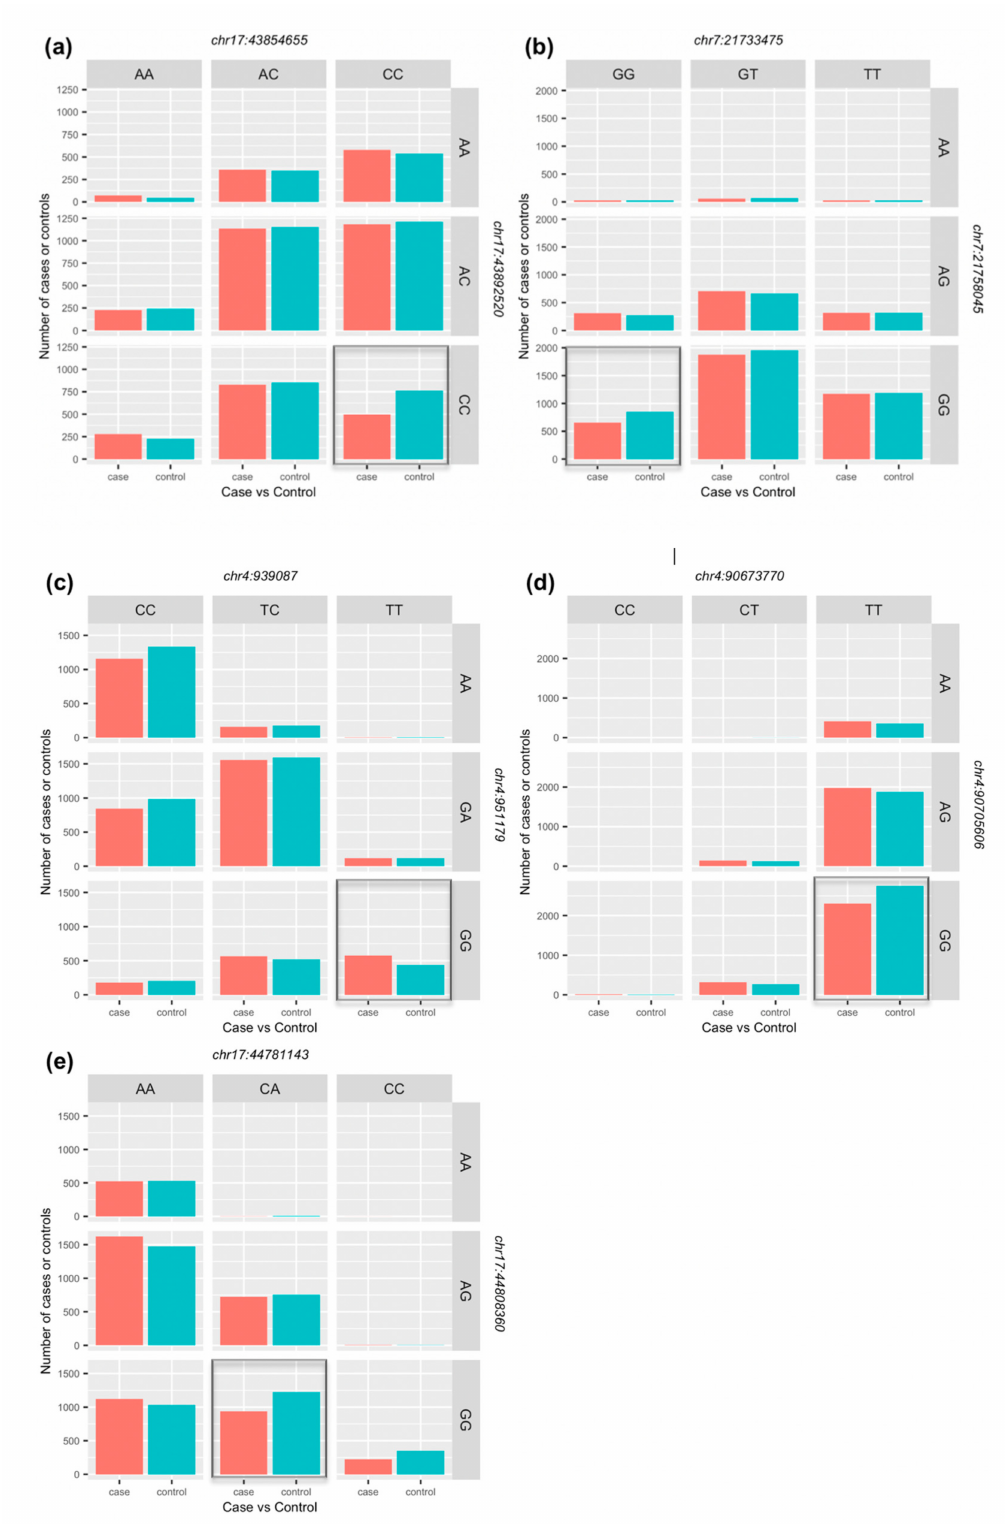
Figure 3. Genotype frequency for the combination of SNPs identified by GenEpi. ( a ) Frequency in cases and controls of each genotype combination of the most significant SNP–SNP interaction effect on PD; ( b ) Frequency in cases and controls of each genotype combination of the SNP–SNP interaction effect identified in novel PD risk loci. ( c – e ) show frequency differences in cases and controls for each genotype combination of the most significant SNP–SNP interactions in other three independent loci. The dark-shaded cell of each figure represents the combination that has the strongest